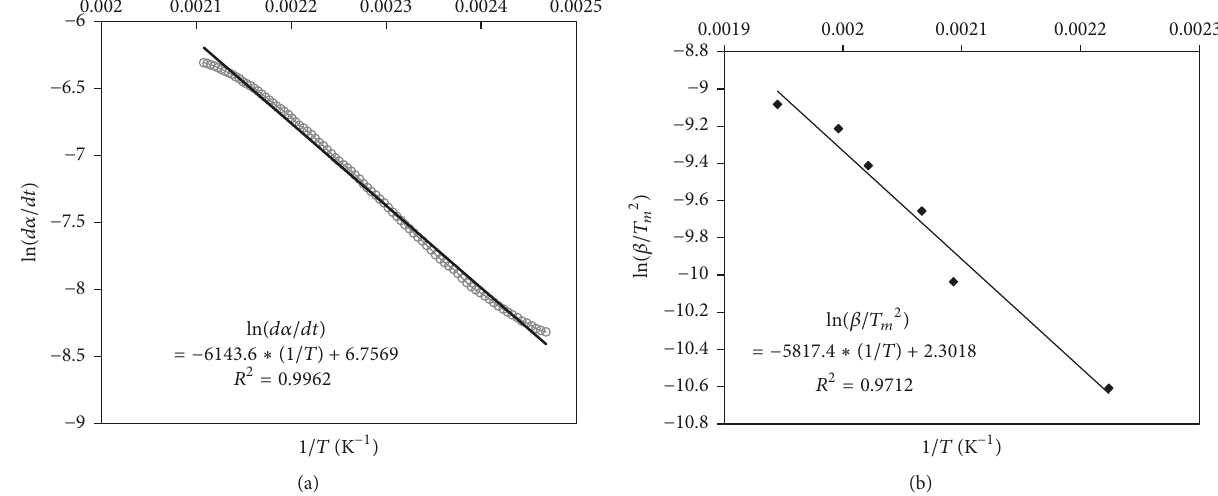
Figure 3: Arrhenius plot (a) and Kissinger plot (b) for the calculation of the activation energy.